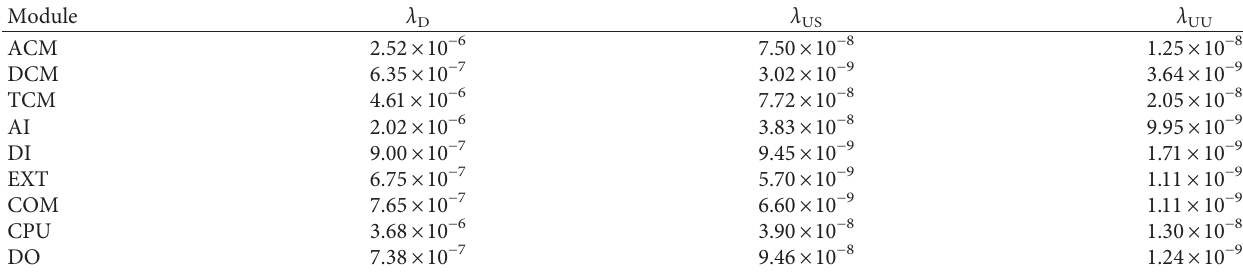
Table 1: Failure rates of components (/h).